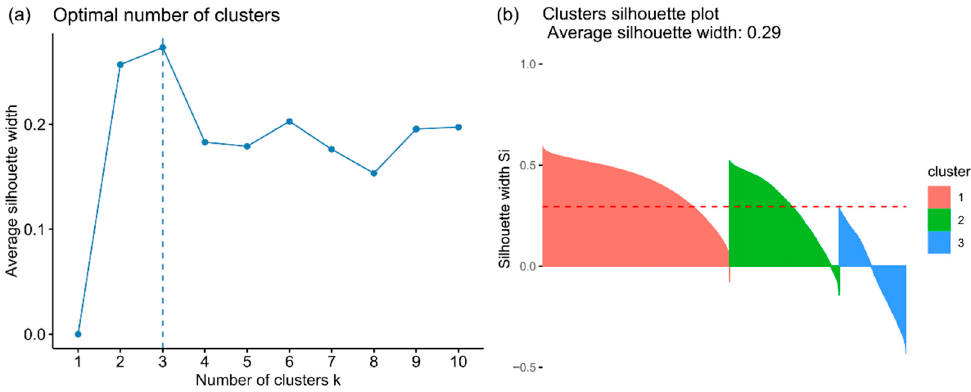
Figure 8. ( a ) The optimal number of clusters determined using average silhouette width statistics; ( b ) The quality of clustering using 3 as the optimal number of clusters based on average silhouette width statistics.